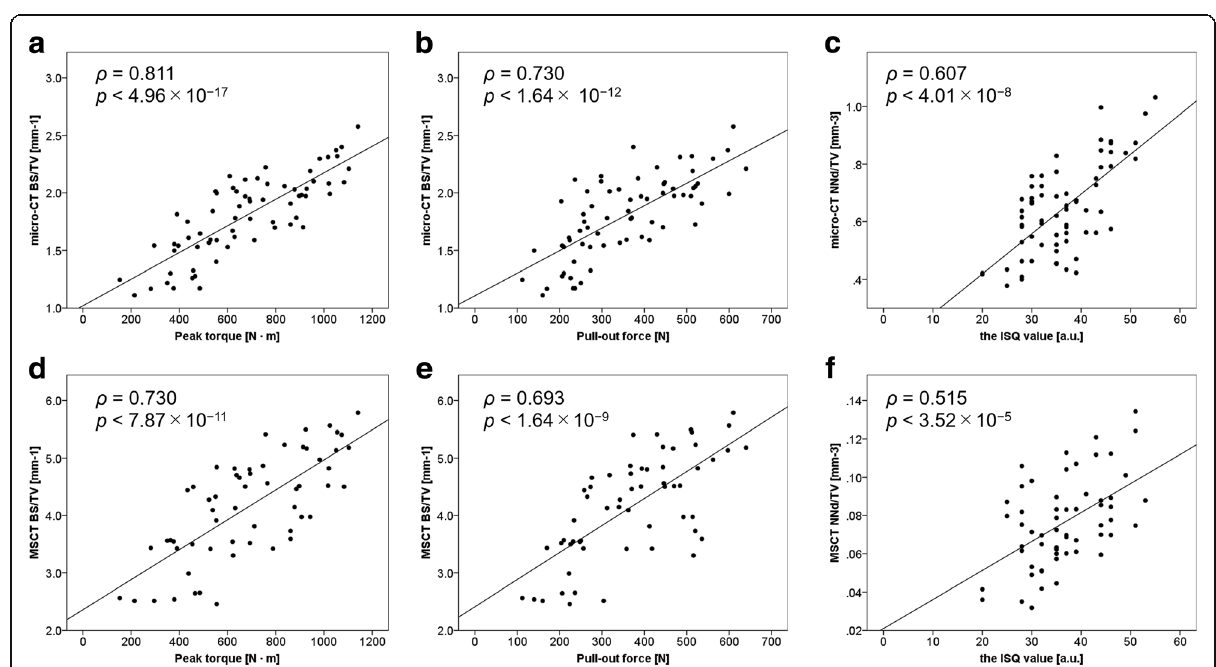
Fig. 5 Scatter plots and best fit lines of linear regression between test forces and micro-architectural parameters (bone surface density) or node number (number of branch points of the cancellous bone network/total volume) on micro-CT and MSCT. a Peak torque versus bone surface density (bone surface [BS]/total volume [TV]) on micro-CT. b Pull-out force versus BS/TV on micro-CT. c Implant stability quotient (ISQ) value versus node number (NNd)/TV on micro-CT. d Peak torque versus BS/TV on MSCT. e Pull-out force versus BS/TV on MSCT. f ISQ value versus NNd/TV on MSCT. N Newton, N m Newton meter, a.u. arbitrary